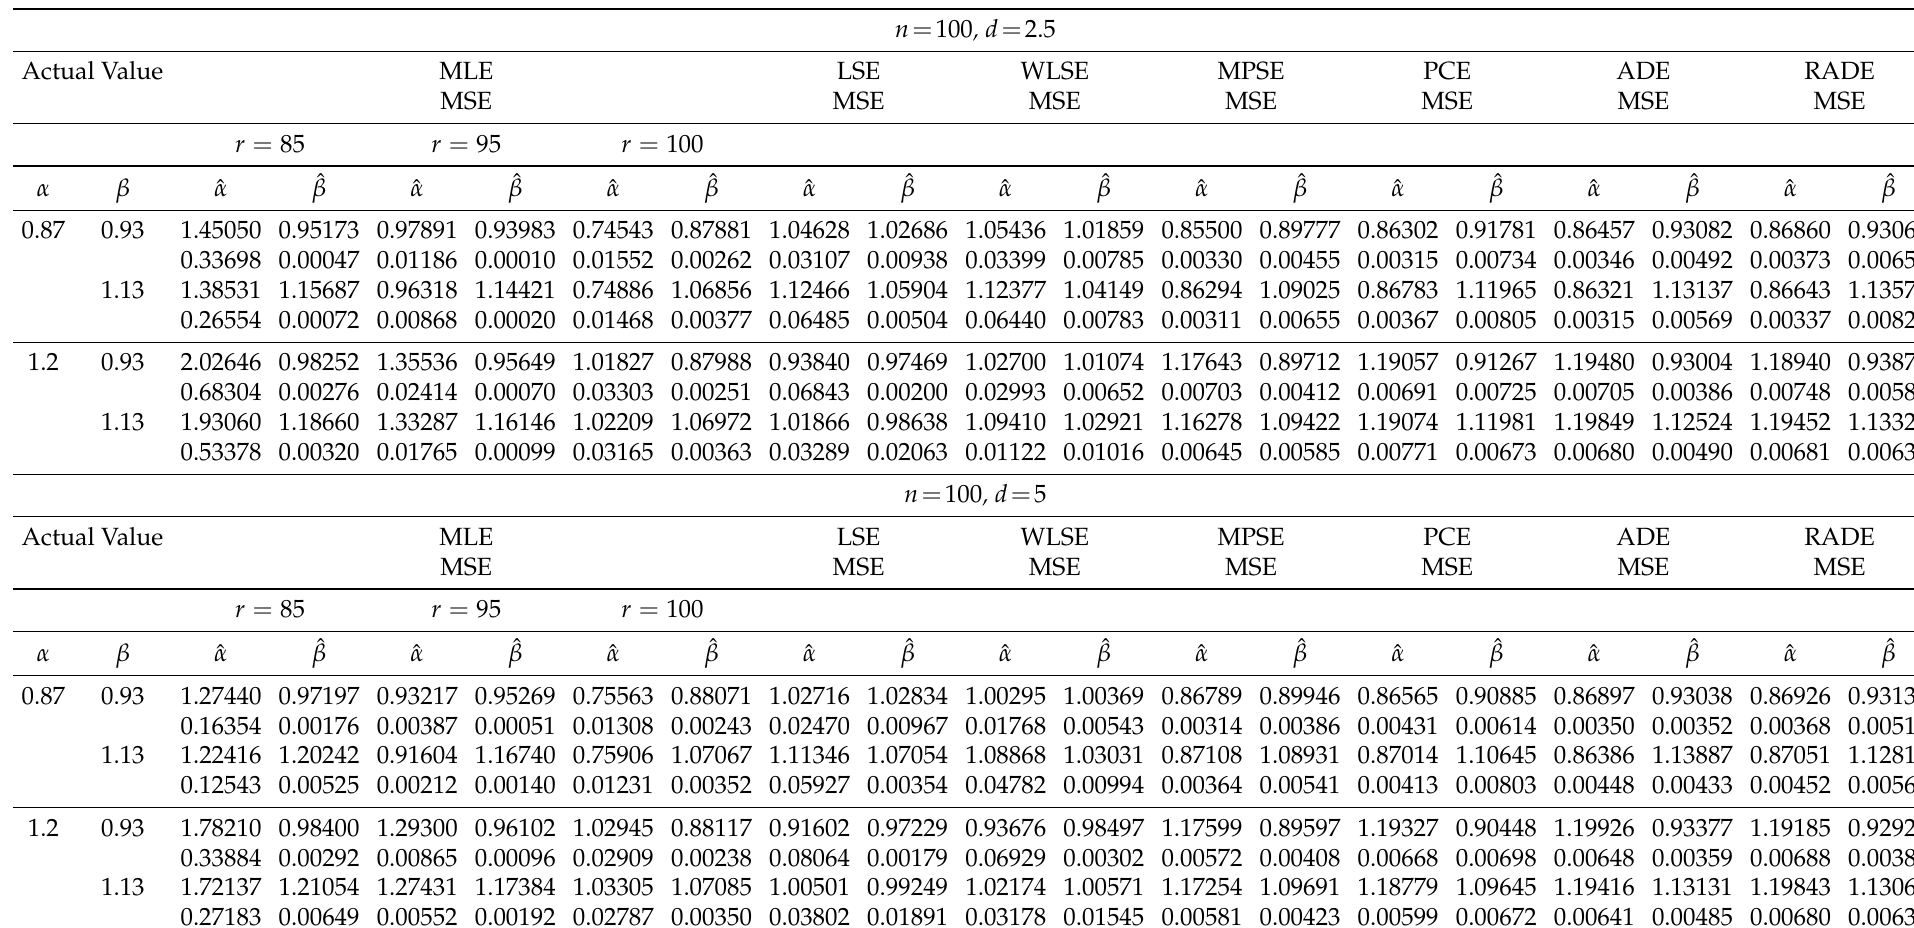
Table 5. The MLEs, LSEs, WLSEs, MPSEs, PCEs, ADEs, RADEs and their